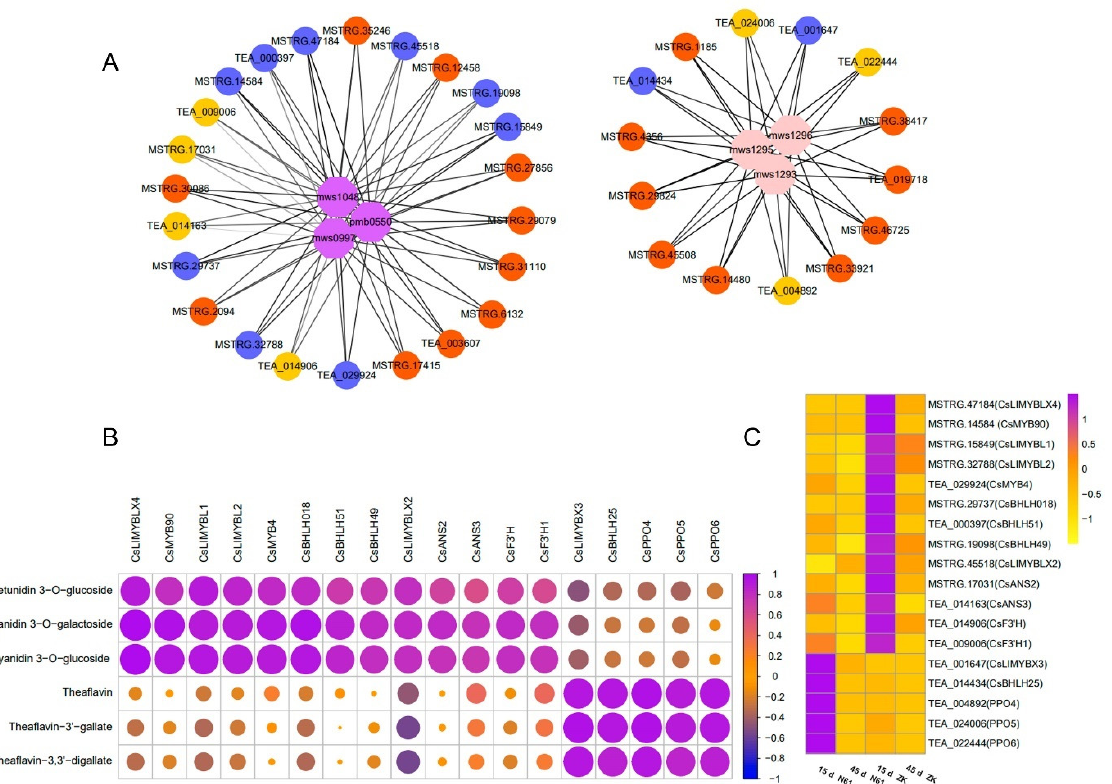
Figure 4. Correlation analysis between genes and key metabolites of purple-leaf formation in Zikui tea. ( A ) Mapping of key metabolites and strongly correlated genes. mws0997, mws1048, and pmb0550 in purple are the metabolites petunidin 3- O -glucoside, cyanidin 3- O -galactoside, and cyanidin 3- O -glucoside, respectively. mws1293, mws1295, and mws1296 in pink are the metabolites theaflavin, theaflavin-3’-gallate, and theaflavine-3, 3’-digallate, respectively. Yellow represents structural genes, and light blue represents transcription factors. Unannotated genes that are highly associated with these metabolites are indicated in orange. The thickness of the line indicates the strength of the correlation. ( B ) Correlation analysis of 18 key genes and key metabolites. ( C ) Heatmap showing the expression levels of 18 key genes, n = 3 independent biological